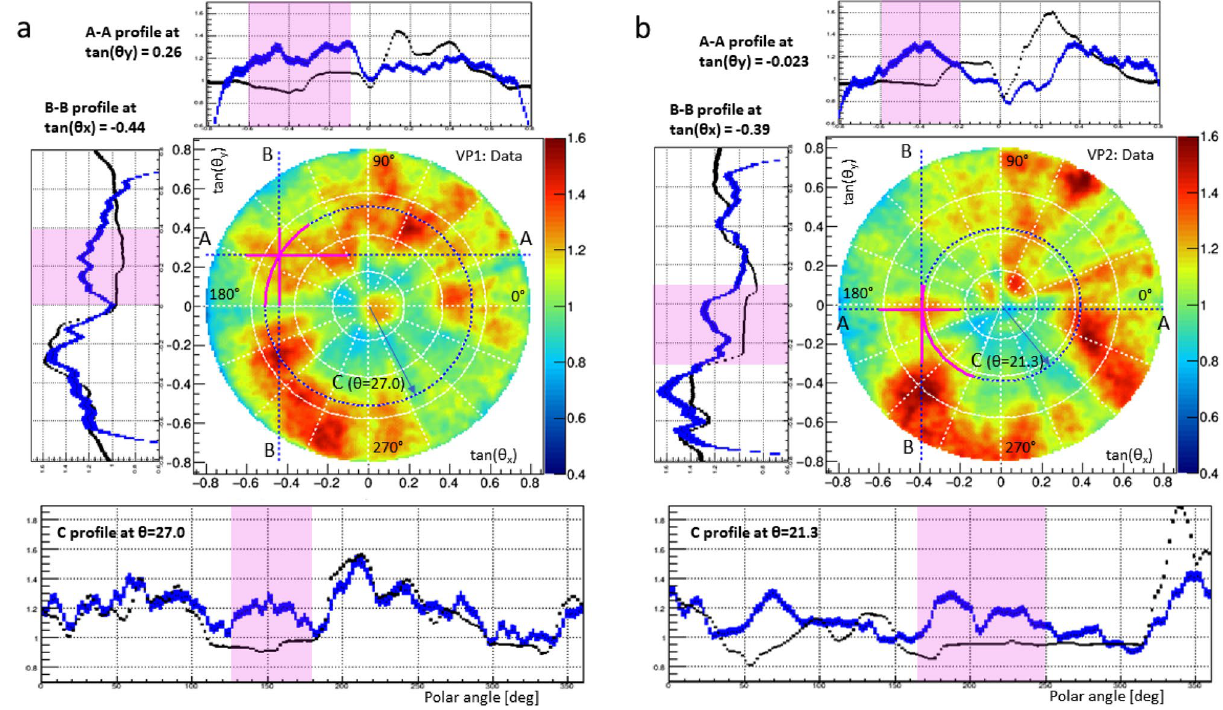
Figure 6. ( a ) The plot in the center is the bi-dimensional muography plot, same as in Fig. 5b. ( b ) The plot in the center is the same as in Fig. 5e. Both plots are accompanied with 3 profiles corresponding to the section lines A-A. B-B and the circumference C. Solid pink segments indicate the anomaly span. On the profile plots these regions are highlighted, the blue line stay for data, black for simulation (shown on Figs 5a and 5d), the vertical error bars represent the statistical uncertainties defined by the bins population with muons. The angles are given in degrees (0–360), the polar one follows east-counterclockwise